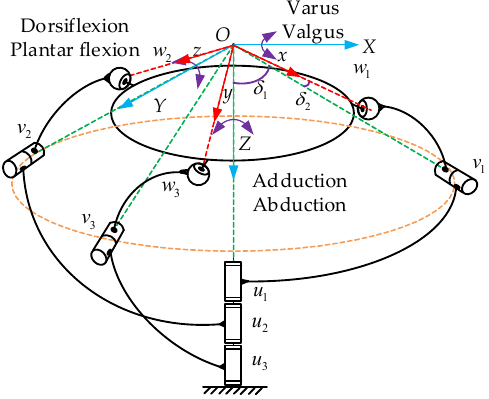
Figure 4. Kinematics model of the 3-RRS parallel mechanism.